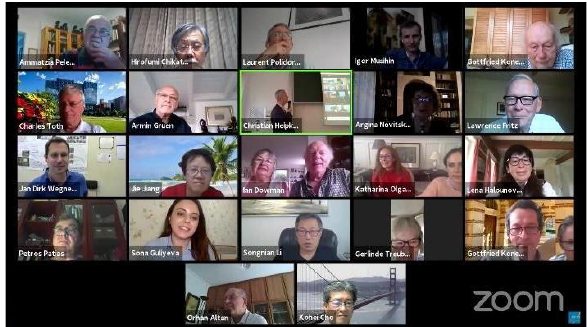
Figure 2. Some of the guests for Dr. Gottfried